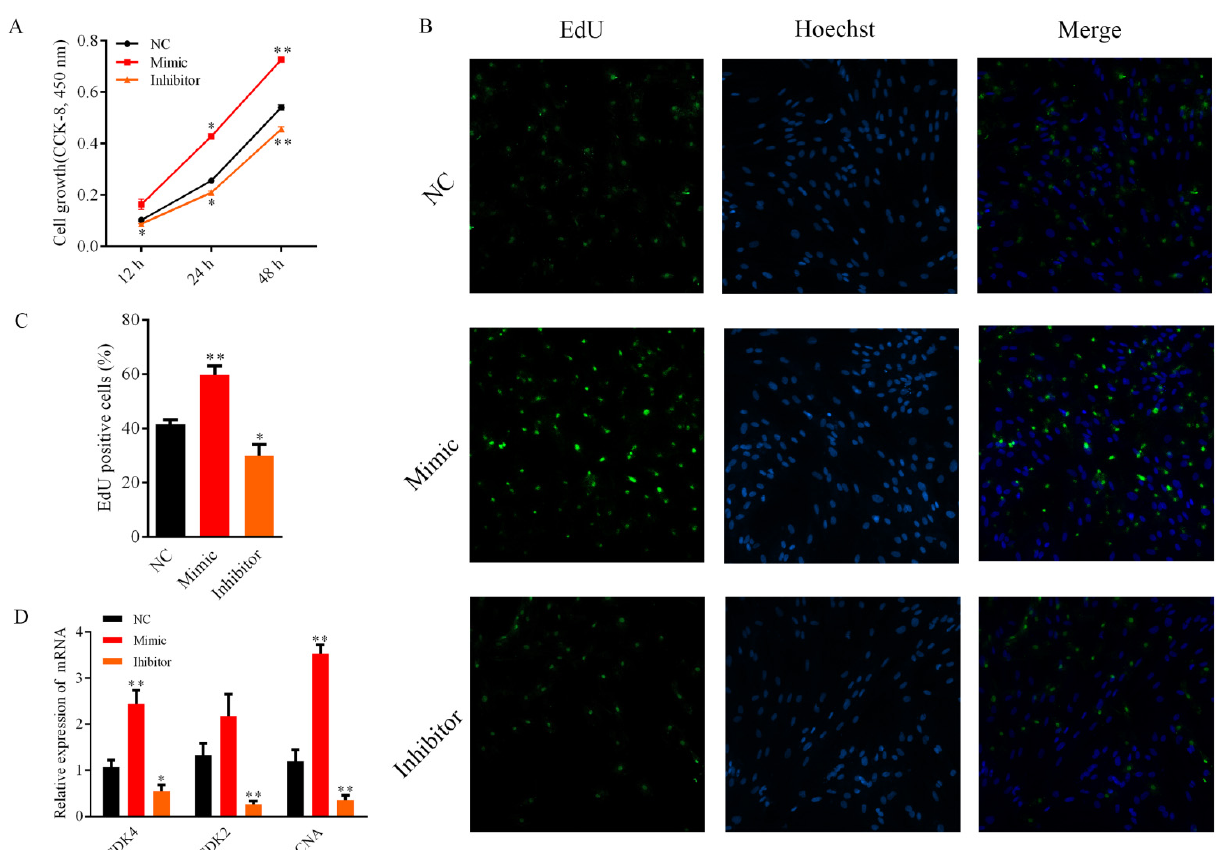
Figure 2. Bta-miR-2400 promotes yak preadipocyte proliferation. Cells were transfected with bta-miR-2400 mimic, NC, and inhibitor. ( A ) Cell Counting kit 8 (CCK-8) assays and ( B , C ) 5-ethynyl-20-deoxyuridine (EdU) proliferation were performed to measure cell proliferation ( n = 6 per treatment per time point, magnification 200×); ( D ) Relative expression of cyclin-dependent kinases 2 (CDK2), cyclin-dependent kinases 4 (CDK4) and proliferating cell nuclear antigen (PCNA). * p < 0.05; ** p < 0.01.